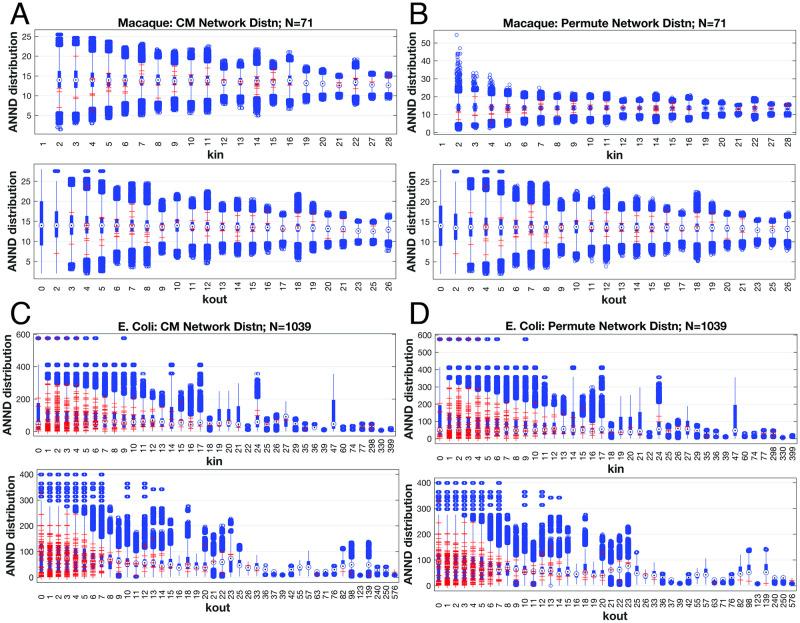
Comparison of null models generated via synthetic network samples with two binary, directed datasets: Macaque cortex (A & B) and metabolic network of E. Coli (C & D).Each dataset provided degree sequences kin and kout in turn used to generate n = 200, 000 samples of synthetically fabricated networks via the CM (left column) or the permutation method (right column). Whisker plots show ANND values comparing synthetic (blue) and original data (red) values. Means (blue circles), one standard deviation (blue vertical lines) and outliers beyond overall encompass the datasets given for the ANND metric within the outlier bands. The two generation methods show similar distributions overall except for the in-bound degree distribution of the macaque cortex where outliers are generated at significantly higher ANND values for low-degree nodes (Panel B).